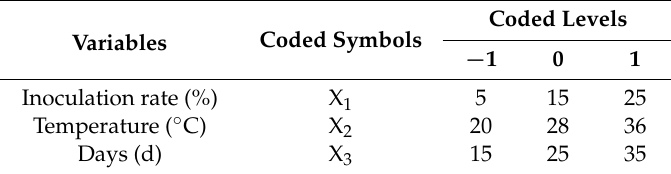
Table 3. Variables and experiments design level for